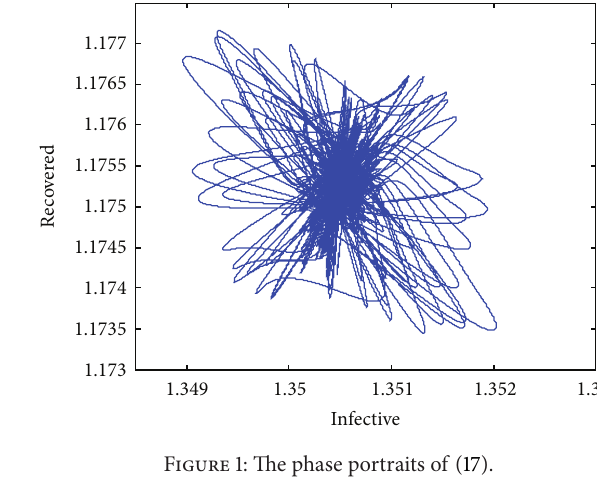
Figure 1: The phase portraits of (17).